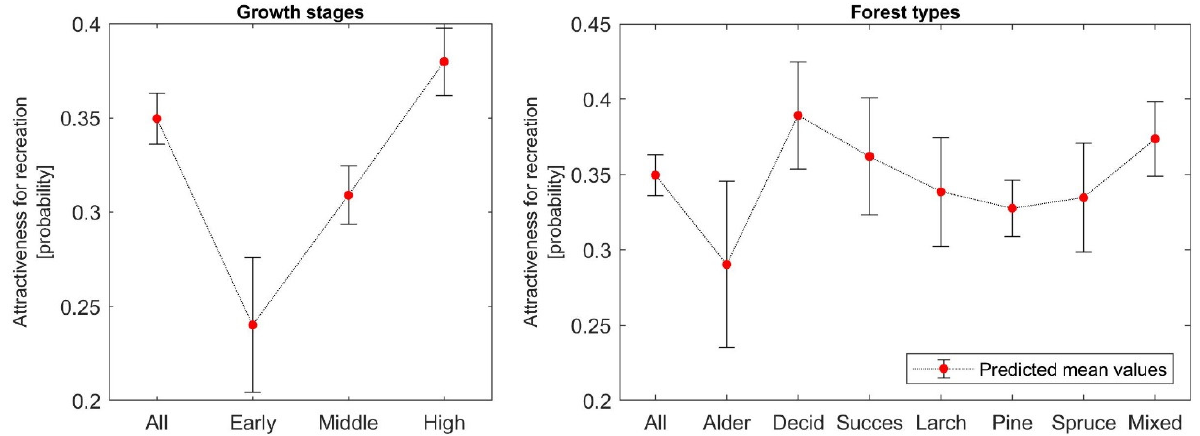
Figure 4. Mean values of the predicted recreation value (attractiveness for recreation) with a 95% confidence interval according to growth stages and forest types.